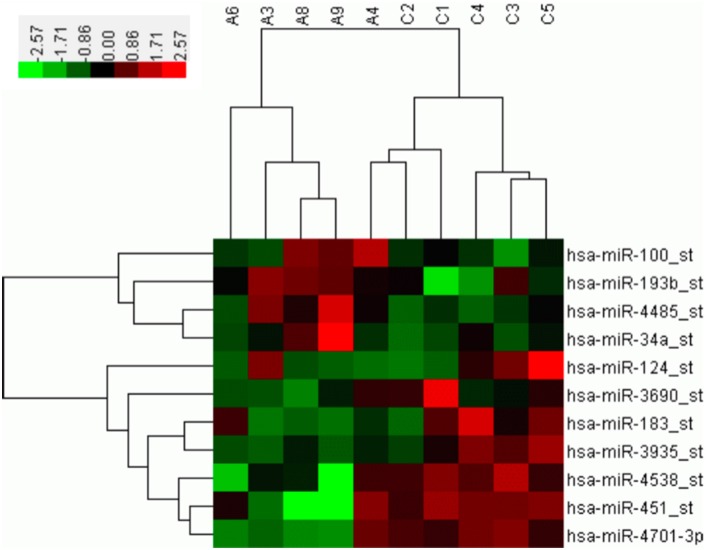
Hierarchical clustering analysis between 5 SALS patients and 5 healthy controls based on differentially expressed miRNAs. The horizontal rows represent the 11 differentially expressed microRNAs, and the columns represent the 10 samples, 5 from the SALS (A) and 5 from the healthy controls (C). Red indicates relative overexpression, and green indicates relative underexpression.